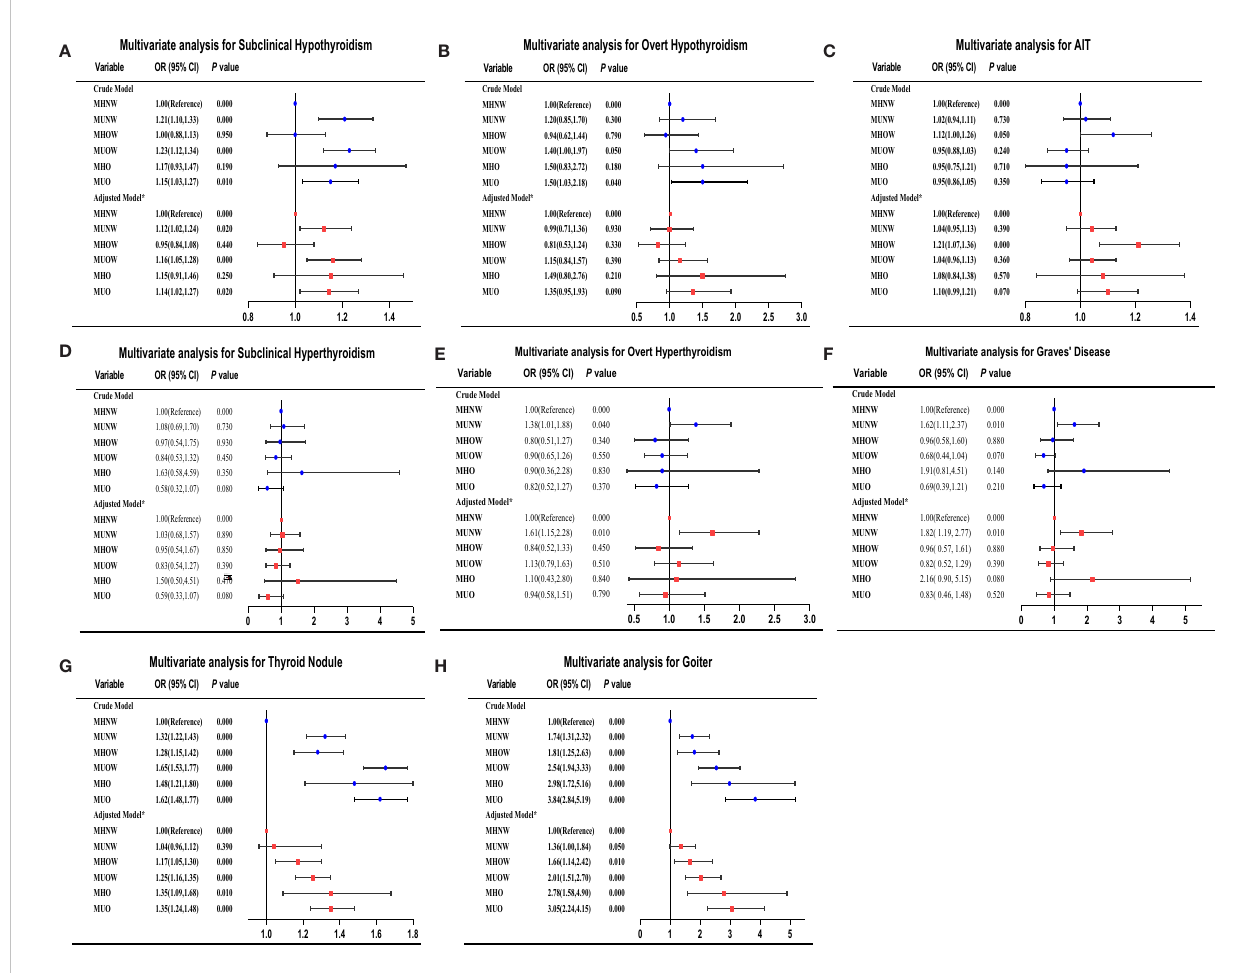
FIGURE 2 Adjusted ORs and CIs estimating the association between different metabolic obesity phenotypes and thyroid disorders. (A) subclinical hypothyroidism; (B) overt hypothyroidism; (C) AIT; (D) subclinical hyperthyroidism; (E) overt hyperthyroidism; (F) Graves ’ disease; (G) thyroid nodules; (H) goiter. CI, con fi dence interval; OR, odds ratio. *Multivariate analysis model adjusted for sex, age, smoking status, educational level, family income, UIC, TPOAbs, and